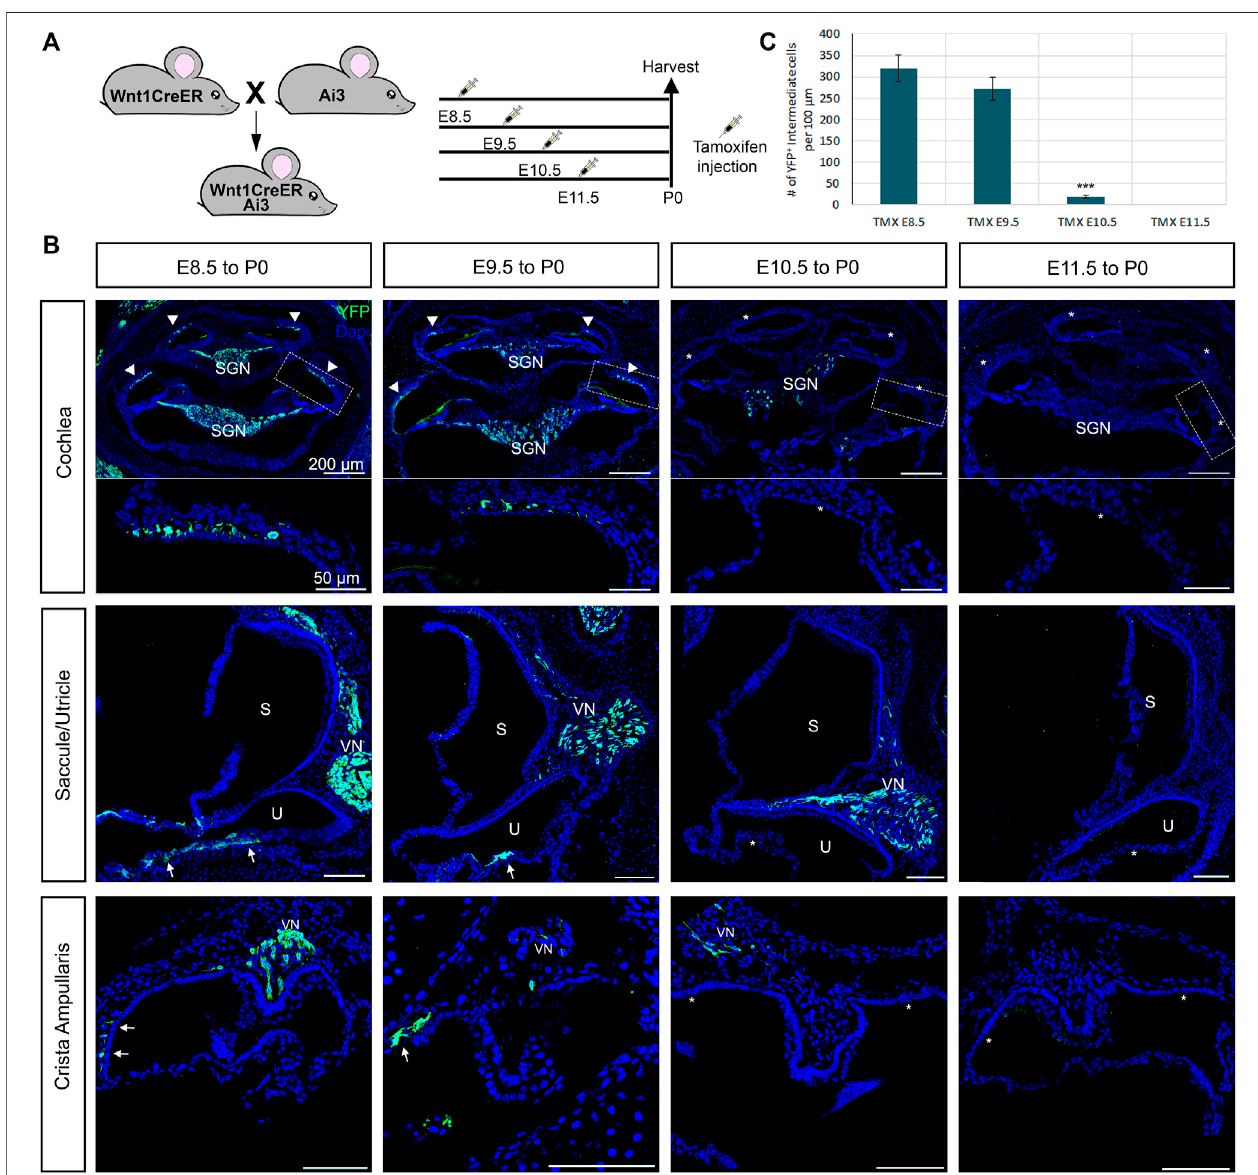
FIGURE5| Earlymigratoryneuralcrestcellsgiverisetobothglialcellsandmelanocytescellsintheinnerear.InducibleWnt1-CreERshowsnolate-migratingneural crestcontributiontotheinnerear. (A) Tamoxifenwasadministeredtopregnantfemalesviaoralgavageattheagesindicatedintheexperimentaldesignandcollectedand analyzedatP0. (B) ImmunostainingofWnt1CreER-YFPmicefollowingtheexperimentaldesignatP0withYFP(green)andDAPIfornuclearlabelling.Arrowsindicatethe melanoblast of the vestibules, the arrowheads the intermediate cells of the stria vascularis and the stars the missing labelling in the melanoblasts and intermediate cells. (C) Graph shows the average number of labeled intermediate cells after administration of tamoxifen at each stage. n = 3. CVN: Cochleo-vestibular neurons; VN: vestibular neurons; SGN: Spiral ganglion neurons; S: saccule; U: utricle.